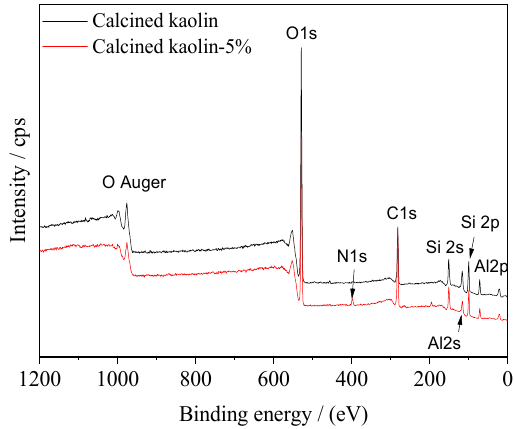
Figure 6. The broad scan XPS spectra of calcined kaolin and calcined kaolin-5%.